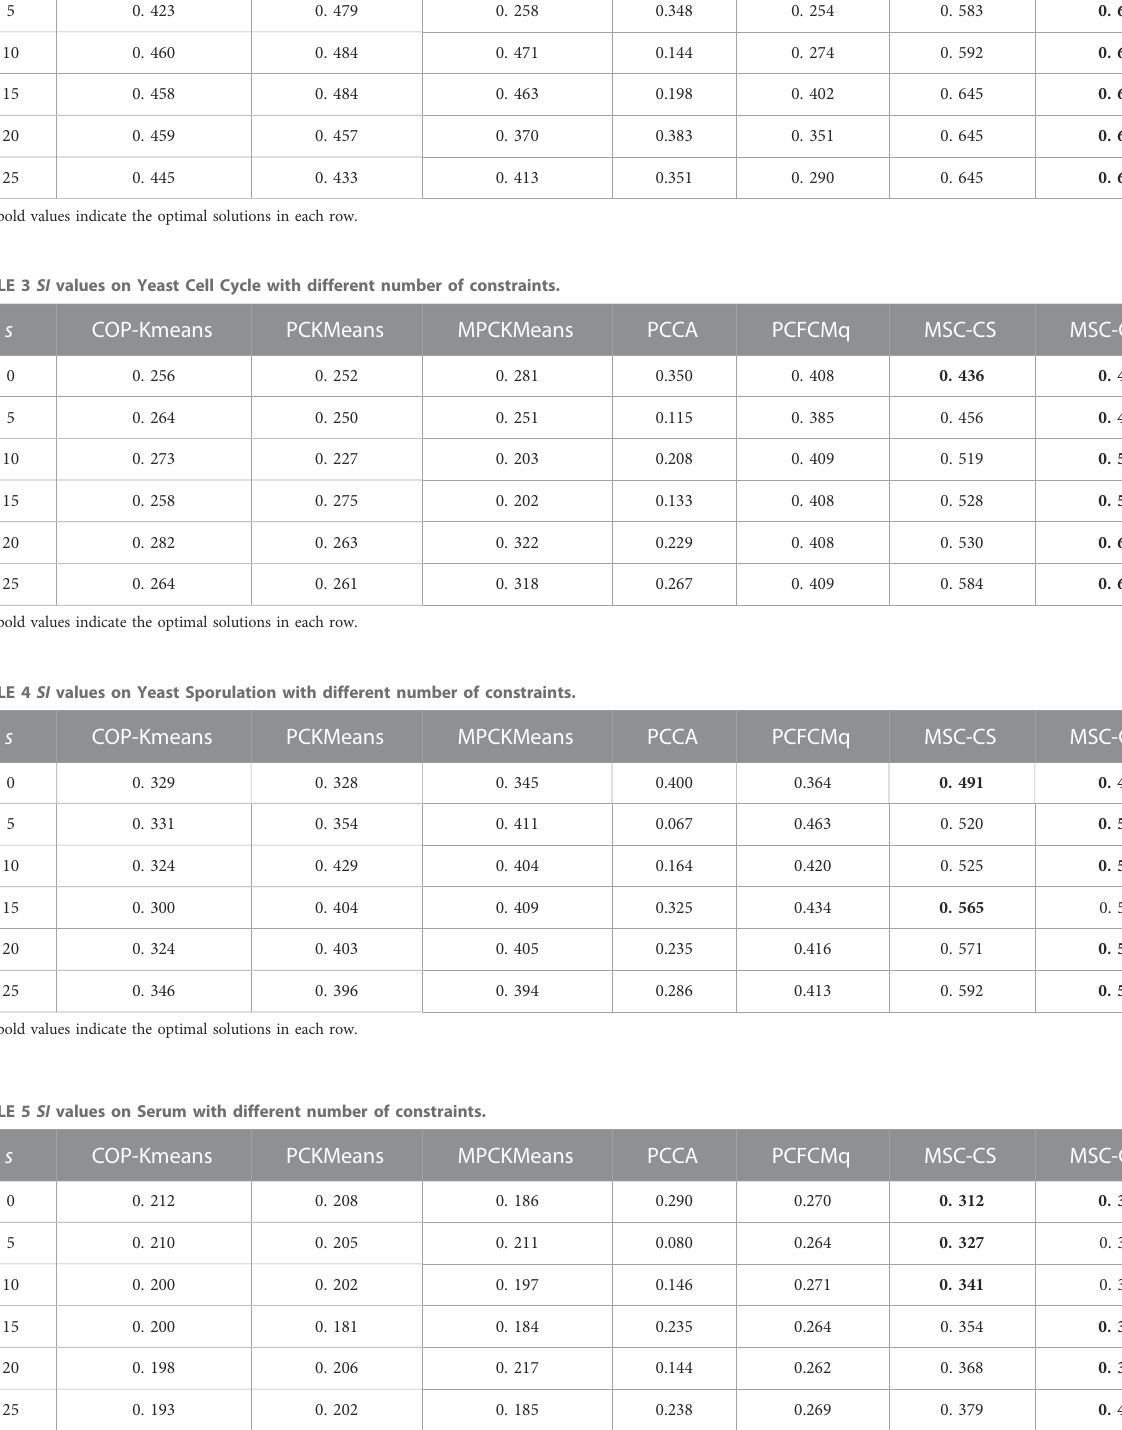
TABLE 2 SI values on Yeast Galactose Metabolism with different number of constraints.